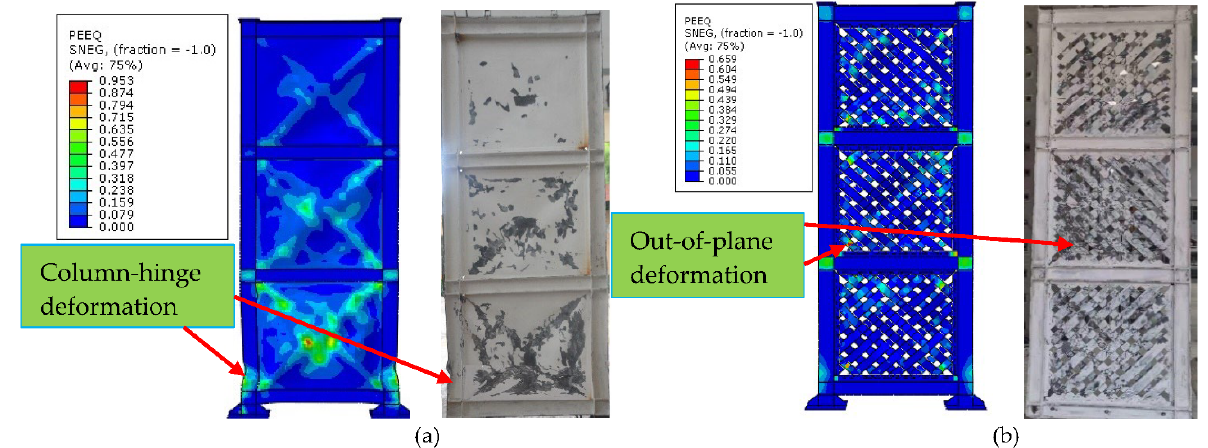
Figure 15. Comparison of the test specimen and FE model failure modes: ( a ) USPSW and ( b ) IWS- SPSW.